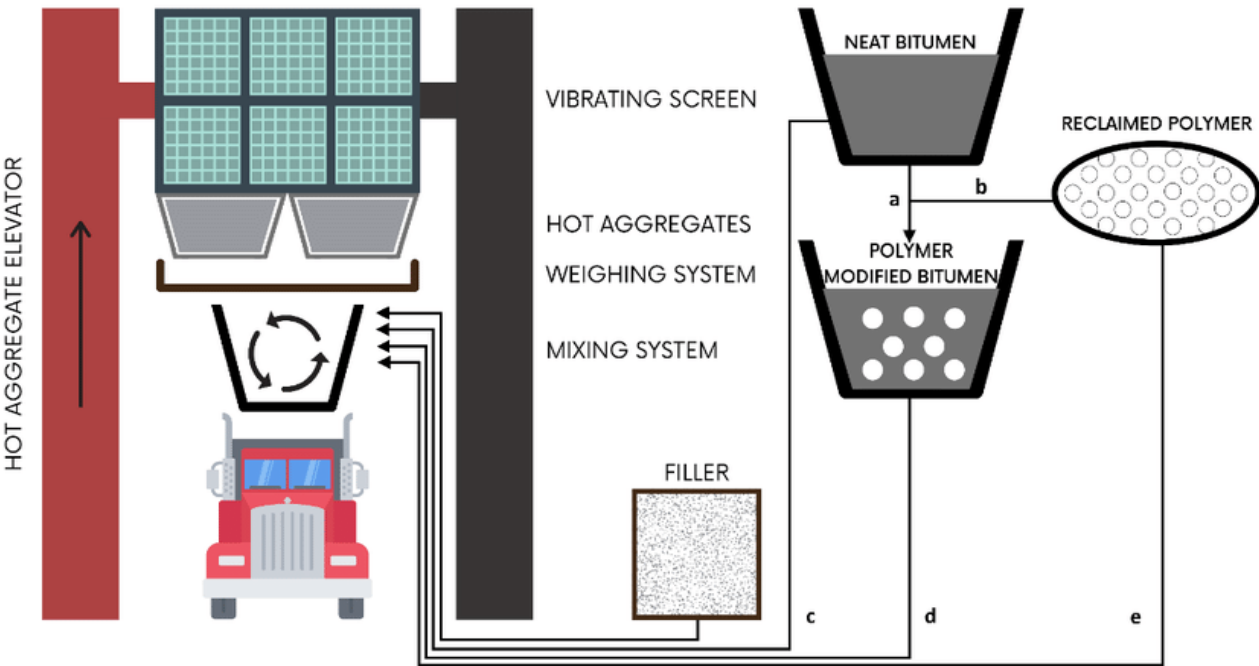
Figure 1. Polymer modification process of mixing by both wet and dry method [24] .